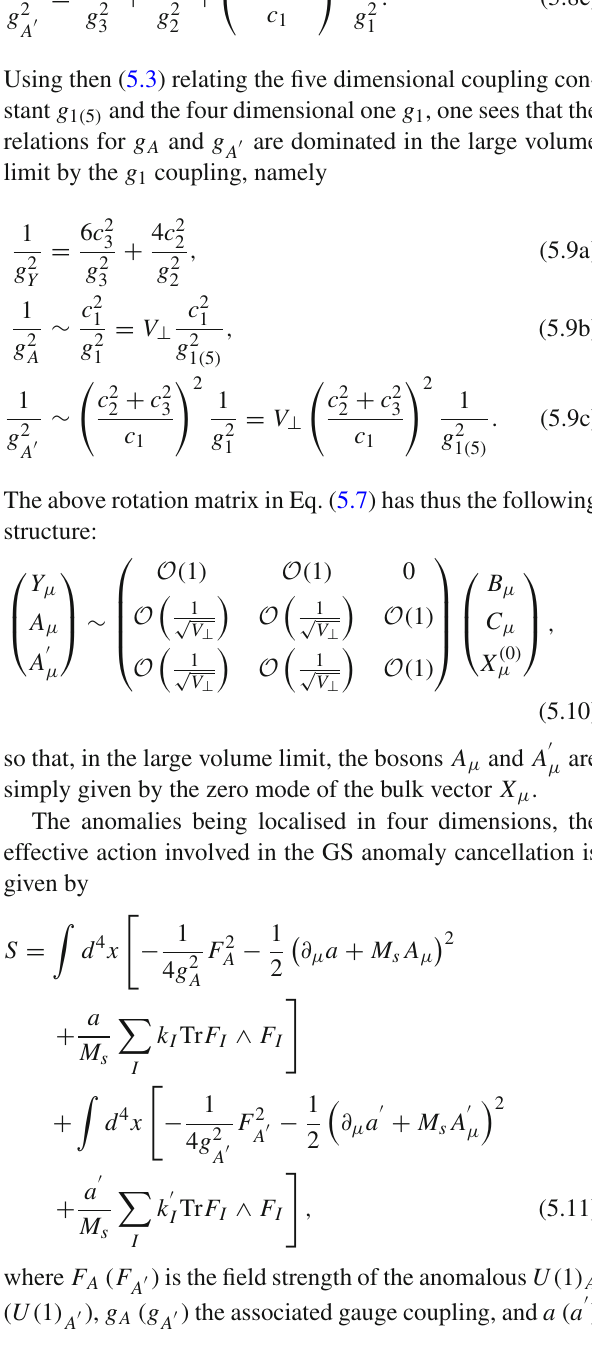
Fig. 3 Dark matter annihilation into SM leptons mediated by the KK ( n ) excitations L μ of the lepton number gauge